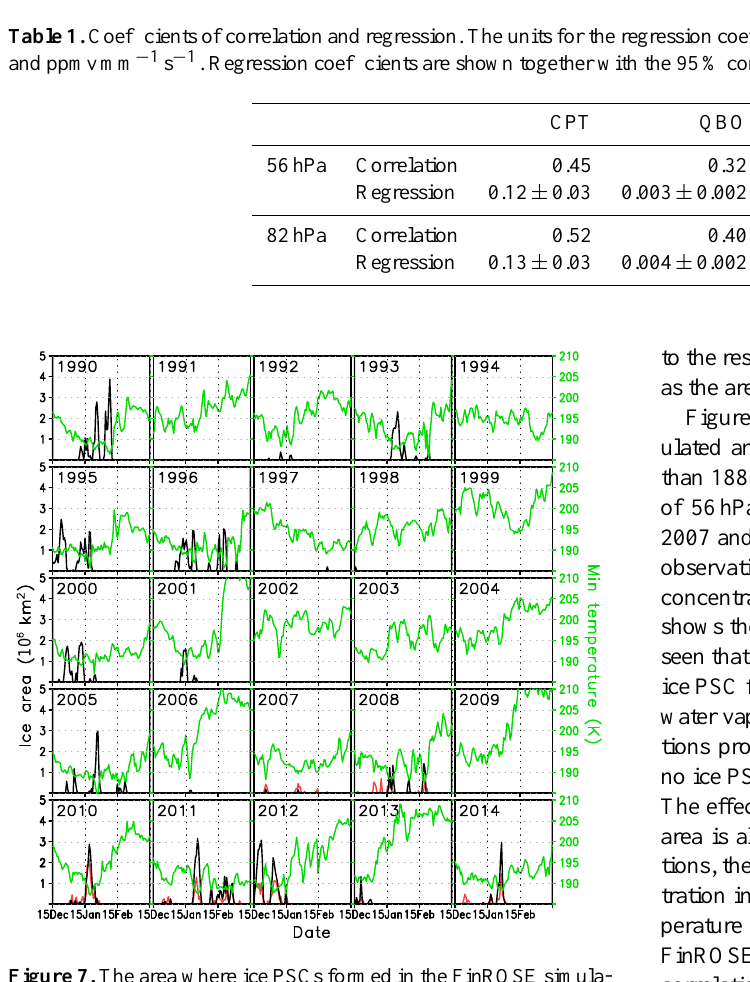
Figure 7. The area where ice PSCs formed in the FinROSE simula- tion (black) and were observed by CALIPSO (red) and the min- imum temperature between 50–90 ◦ N from ERA-Interim (green, right y axis) for winters between 1990 and 2014 at